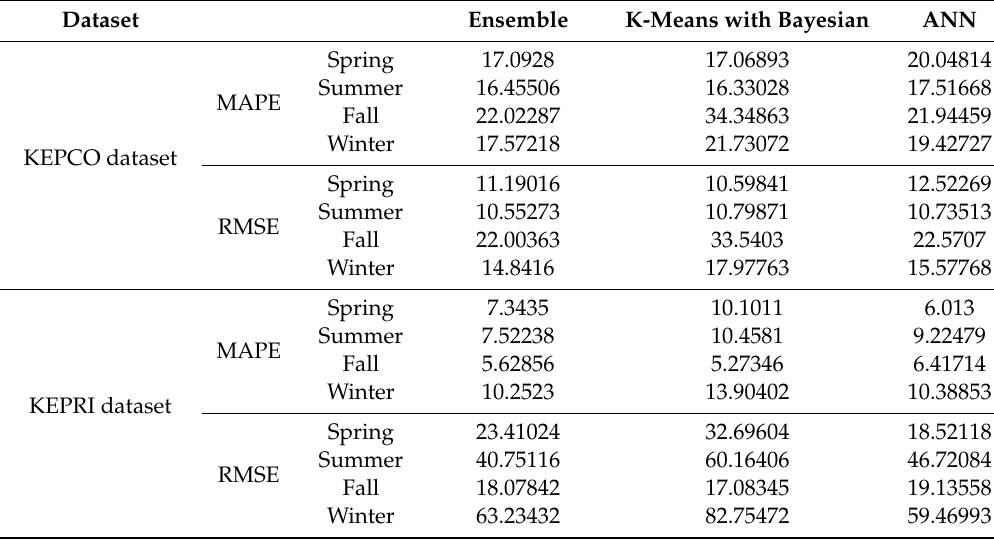
Table 4. Prediction accuracy of forecasting Table 4 . Prediction accuracy of forecasting dataset .